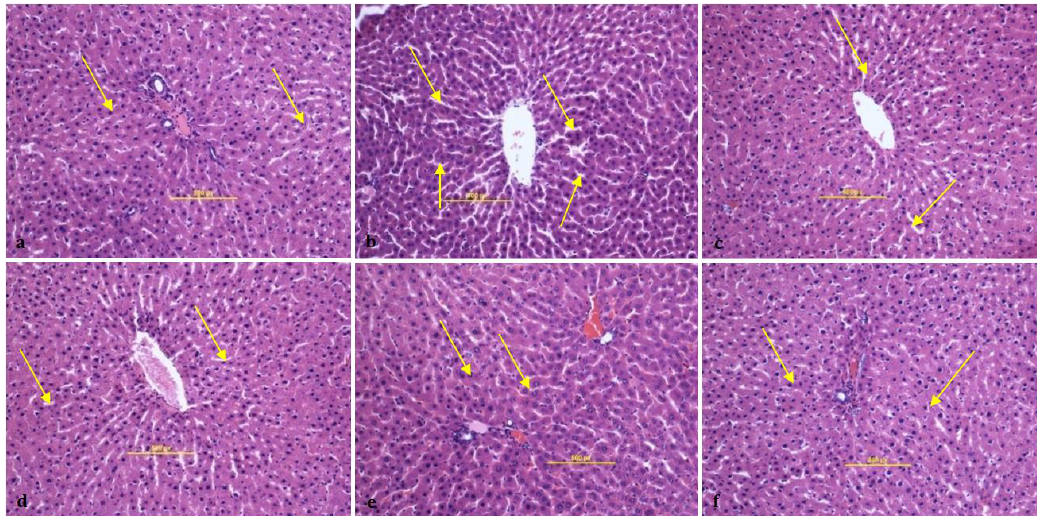
Figure 6 Histopathological changes in the liver of normal and experimental rats. All the sections are in H&E 40X. (a) Control rat Liver shows portal triad surrounded by hepatocytes (yellow arrow). (b) Diabetic rat (showing the periportal fatty infiltration) (yellow arrow). (c) Diabetic rat + 100 mg/kg of MPMTE (showing the periportal fatty infiltration) (yellow arrow). (d) Diabetic rat + 200 mg/kg of MPMTE (showing the periportal fatty infiltration) (yellow arrow). (e) Diabetic rat + 400 mg/kg of MPMTE (portal track showing normal features) (yellow arrow). (f) Diabetic + 100 mg/kg of Metformin (portal track showing normal features) (yellow